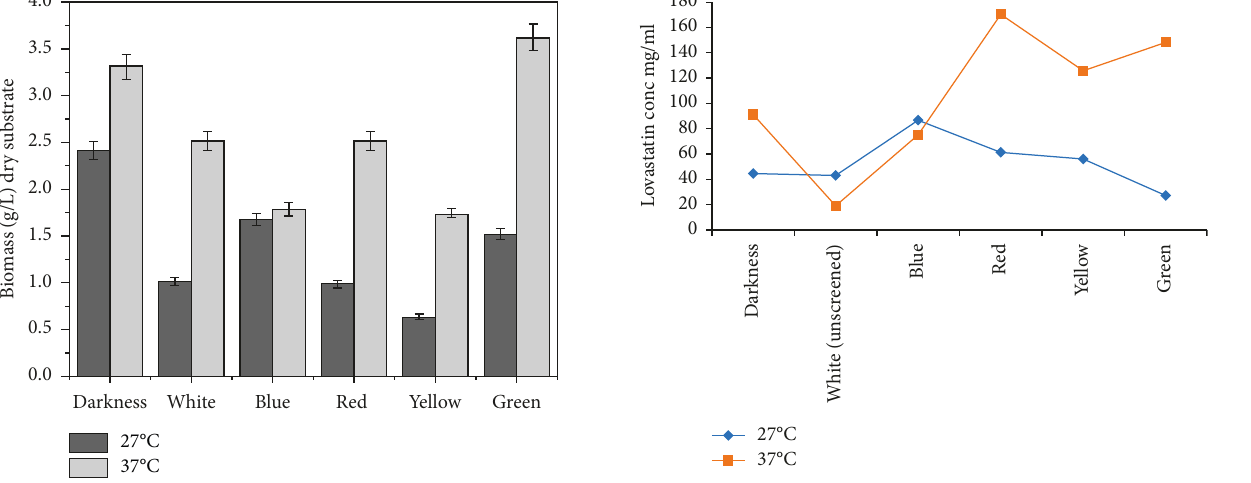
Figure 3: Effect of biomass production different wavelengths of light on Monascus ruber .